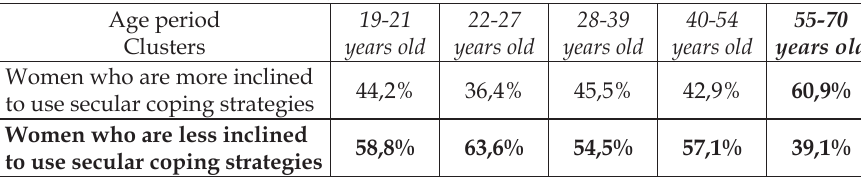
Table 1. Percentage ratio in women of different age with different tendency to use secular ways of overcoming dif fi